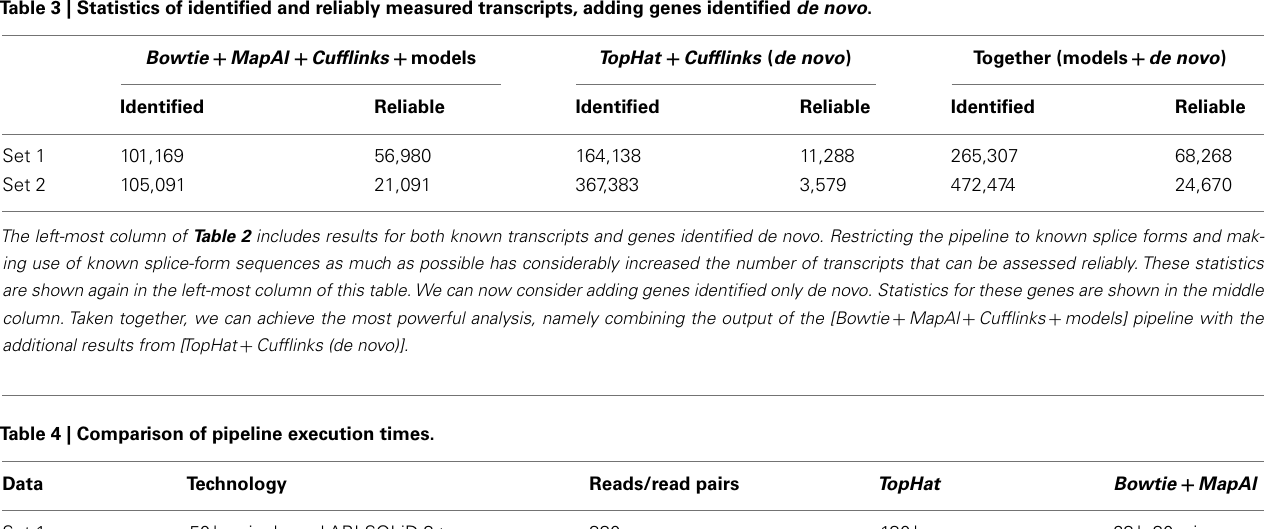
FIGURE 3 | Distribution of measurement errors. Each of the plots compares the distributions of measurement errors for TopHat (red line) and MapAl (black line).The x -axis shows the SD across three replicate measurements on the log scale.The dashed vertical line marks an error of 20%.The y -axis